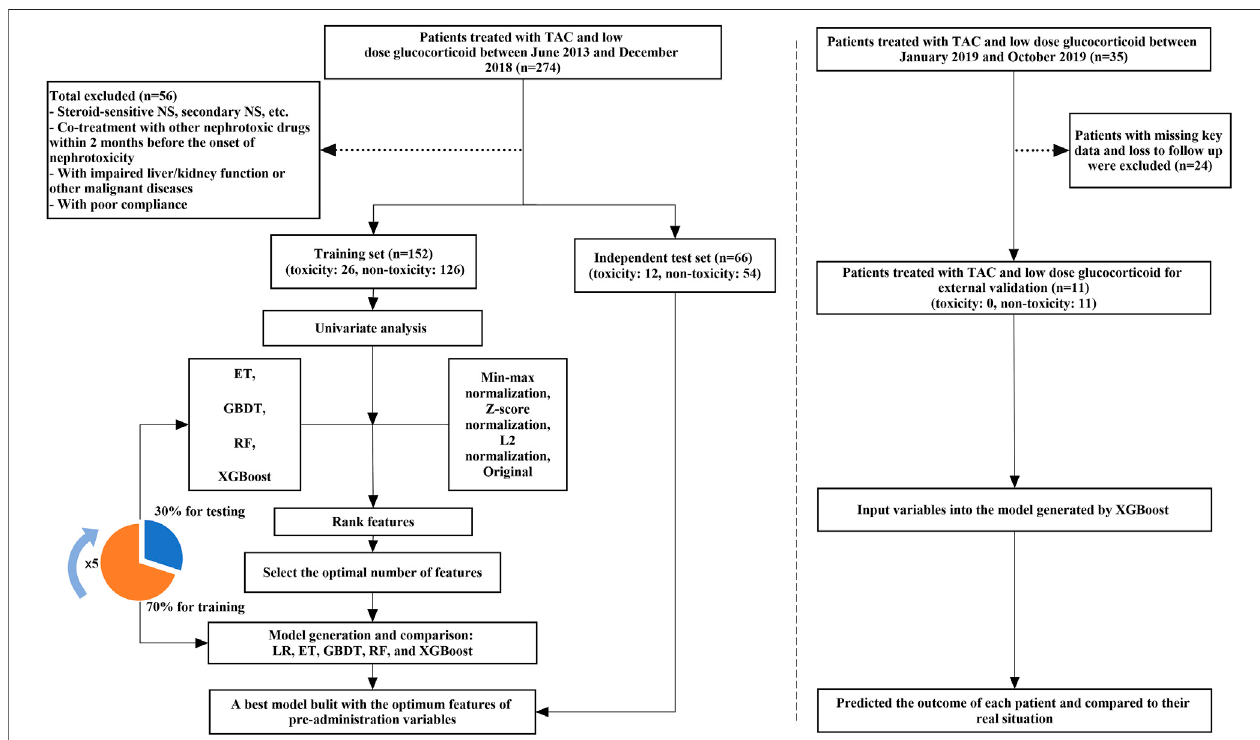
FIGURE 1 | The fl owchart of model generation and validation. The left side of the dotted line is the process of model generation, while the right side is the external validation of the model. ET, Extremely Randomized Trees; GBDT, Gradient Boosting Decision Tree; LR, Logistic Regression; RF, Random Forest; XGBoost, eXtreme Gradient